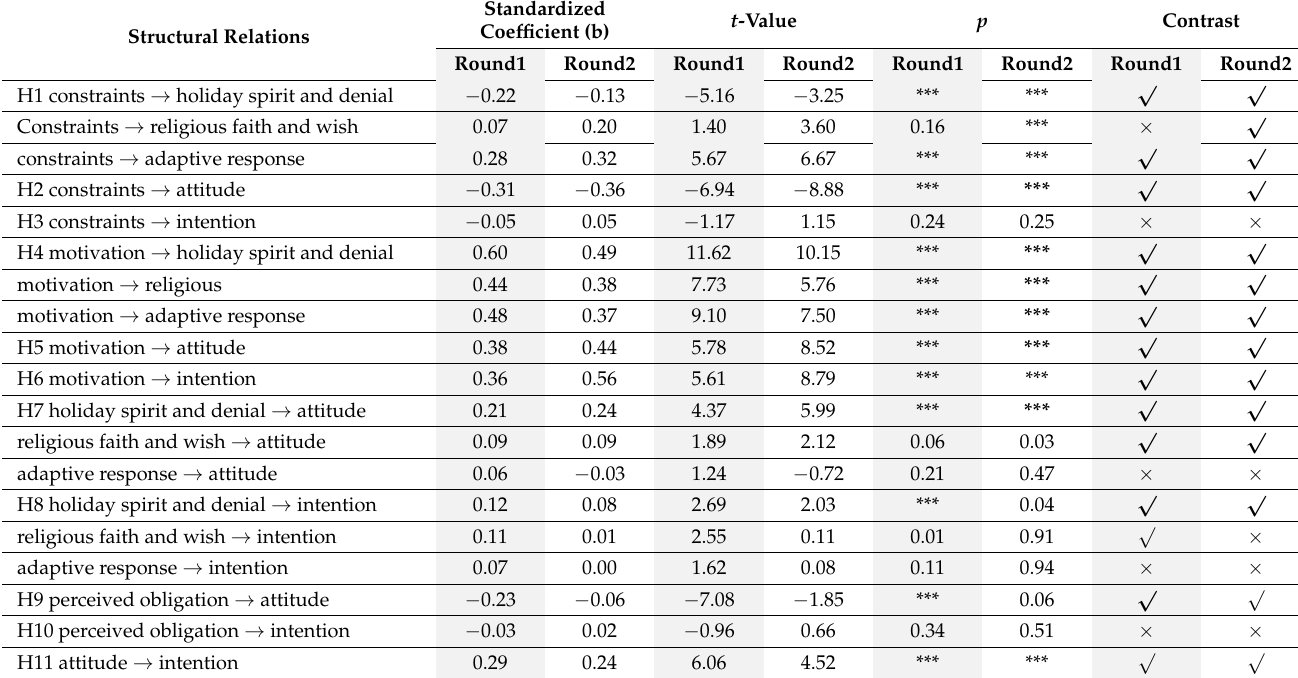
Table 4. Summary of hypotheses test